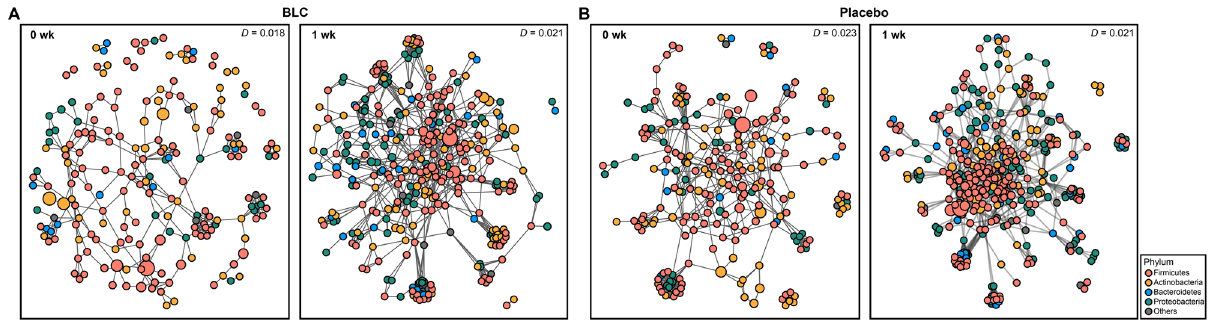
Figure 5. Network analysis of the axillary microbiome at the bacterial operational taxonomic unit (OTU) level. ( A ) Network analyses of the bioconverted product treatment at 0 week and 1 week. ( B ) Network analyses of the placebo at 0 week and 1 week. Color markings indicate the phylum. Each node represents the OTUs, and the size of each node corresponds to the relative abundance. The D values, which represent the density, were calculated using the ratio of the number of